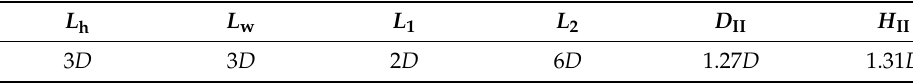
Table 3. Geometrical parameters of computational domain.